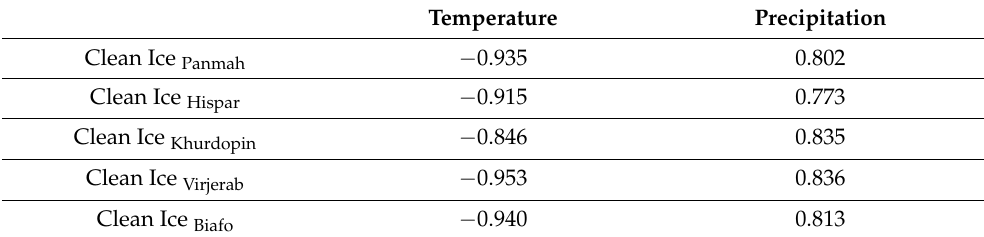
Table 4. Pearson correlation of clean ice with temperature and precipitation.